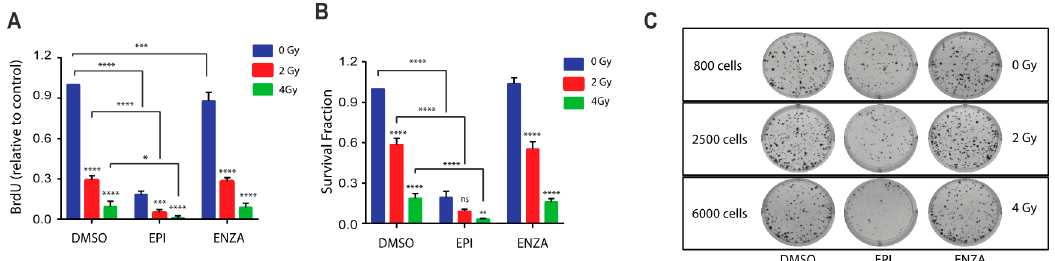
Figure 4. Combination therapy of ralaniten plus ionizing radiation (IR) decreases cell growth and colony formation, whereas enzalutamide has no added benefit. ( A ) LNCaP95 cells were treated with DMSO, ralaniten (EPI-002, 35 µ M), ENZA (5 µ M) and then 2 h later received 0, 2, and 4 Gy dose of IR. Proliferation was measured 48 h after IR using the BrdU incorporation assay. Data represent the average relative to vehicle control of n = 3 independent experiments ± SEM. ( B ) LNCaP95 cells were treated similarly to above and incubated for 14 days to allow colony formation. Colonies were stained with crystal violet and counted using Image J software to calculate the survival fraction. Data shown represent the mean ± SEM from n = 3 independent experiments. ( C ) Representative images from the colony formation assay showing the cell numbers at the start of each experiment. ** p < 0.01, *** p < 0.001, **** p < 0.0001; ns, not significant. Two-way ANOVA with Tukey’s multiple comparison test was used.